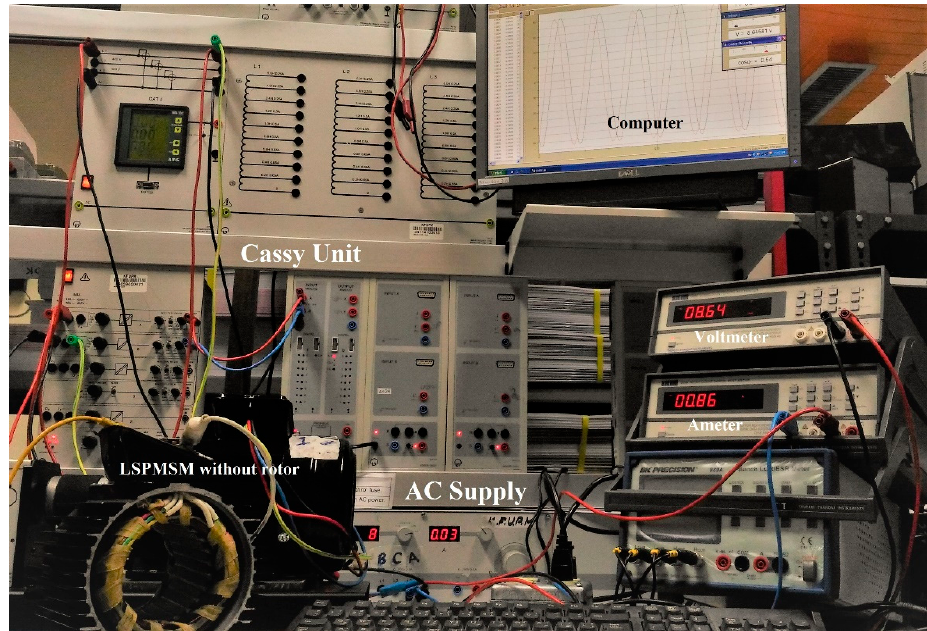
Figure 7. Experimental set-up for single phase AC test without rotor.